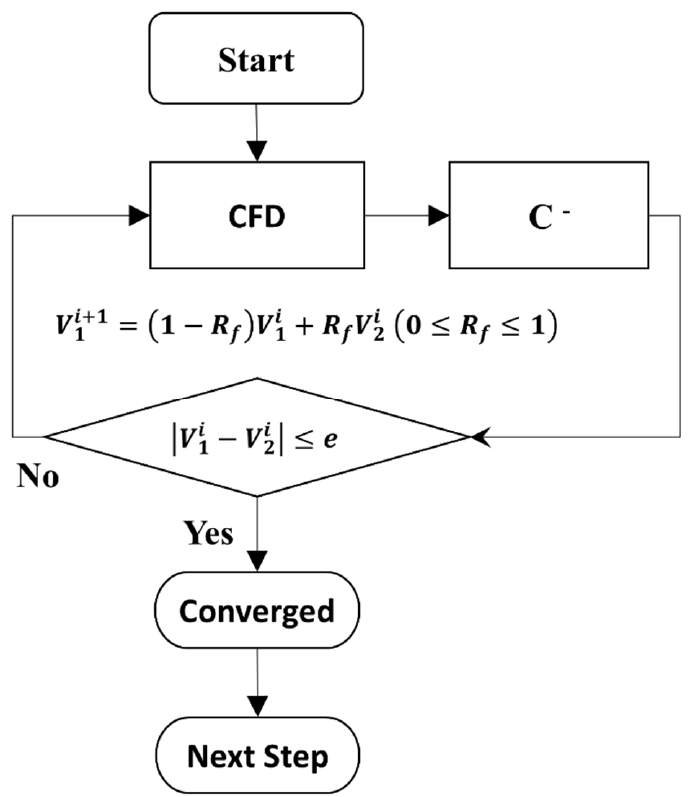
Figure 3. Iteration loop in the 1D-CFD coupling.